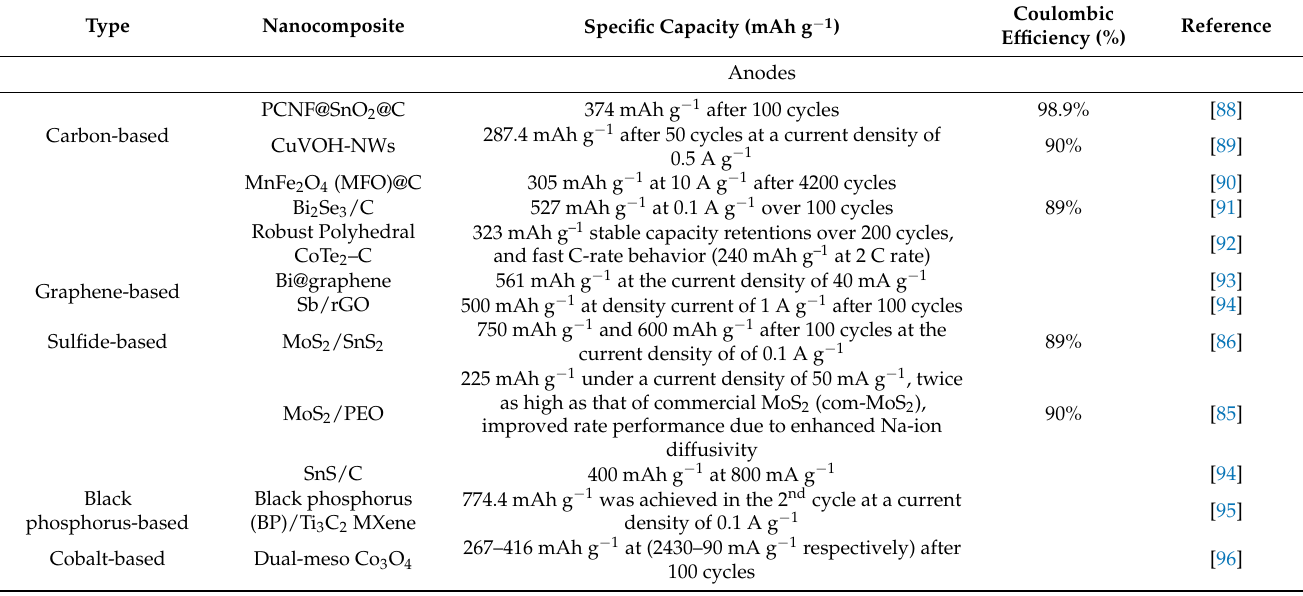
Table 4. Application of nanocomposites in sodium-ion batteries (NIBs) and their electrochemical performance as electrodes, based on review